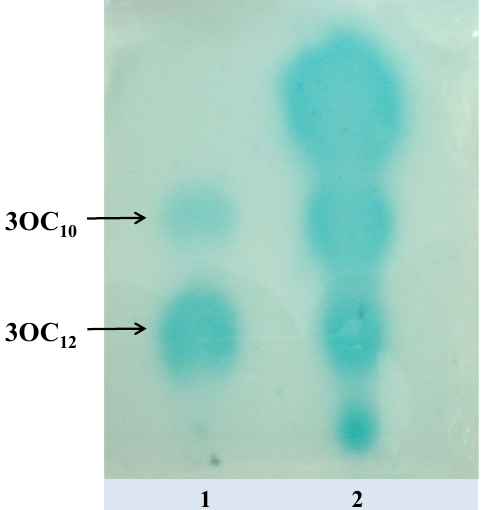
Figure 2. Detection of AHLs with long acyl chain by thin layer